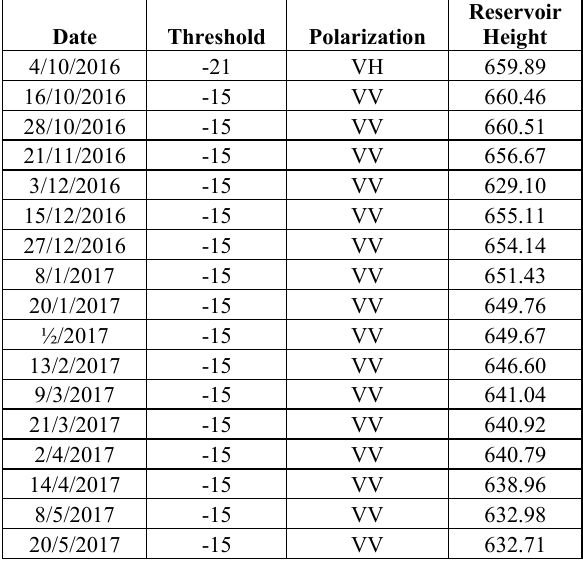
Table 1. Satellite data acquisition dates, threshold used